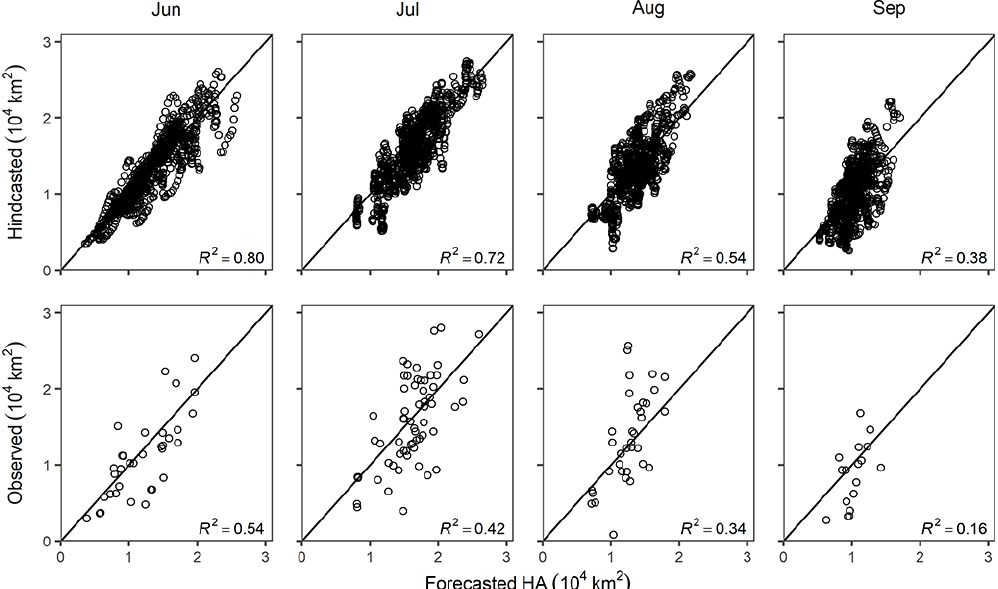
Figure 4. Month-by-month comparison of the daily hindcasted (top) and observed (geostatistically estimated; bottom) shelf-wide HA versus pseudo-forecasted HA. The diagonal line represents perfect prediction.